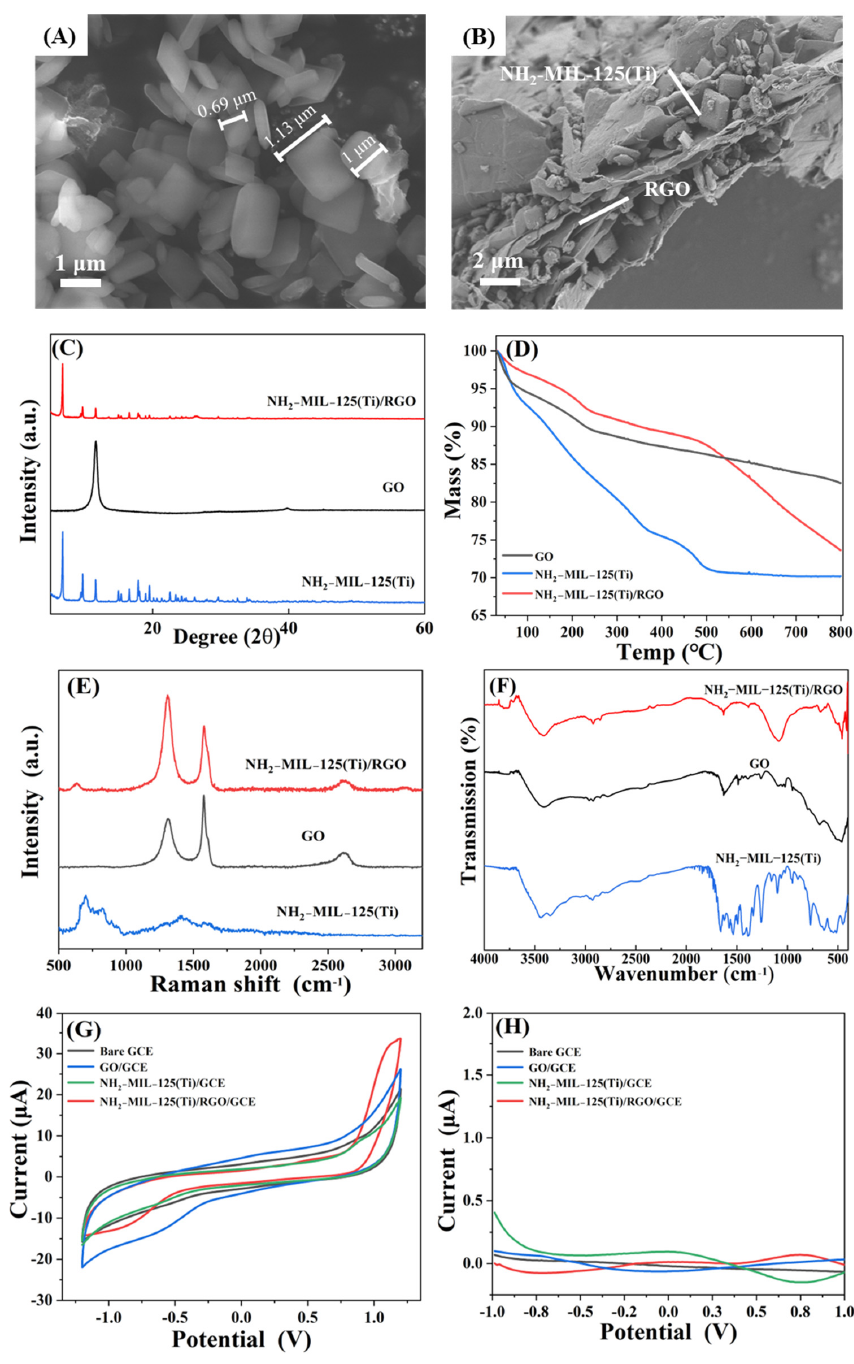
Figure 1. SEM images of ( A ) NH 2 − MIL − 125(Ti) and ( B ) NH 2 − MIL − 125(Ti)/RGO; ( C ) XRD patterns, ( D ) TGA analysis, ( E ) Raman spectra and ( F ) FTIR spectra of GO, NH 2 -MIL-125(Ti) and NH 2 -MIL- ( D ) TGA analysis, ( E ) Raman spectra and ( F ) FTIR spectra of GO, NH 2 − MIL − 125(Ti) and NH 2 − MIL − 125(Ti)/RGO. ( G ) CV and ( H ) DPV curves in 0.1 M PBS at different modified GCEs. 125(Ti)/RGO. ( G ) CV and ( H ) DPV curves in 0.1 M PBS at different modified